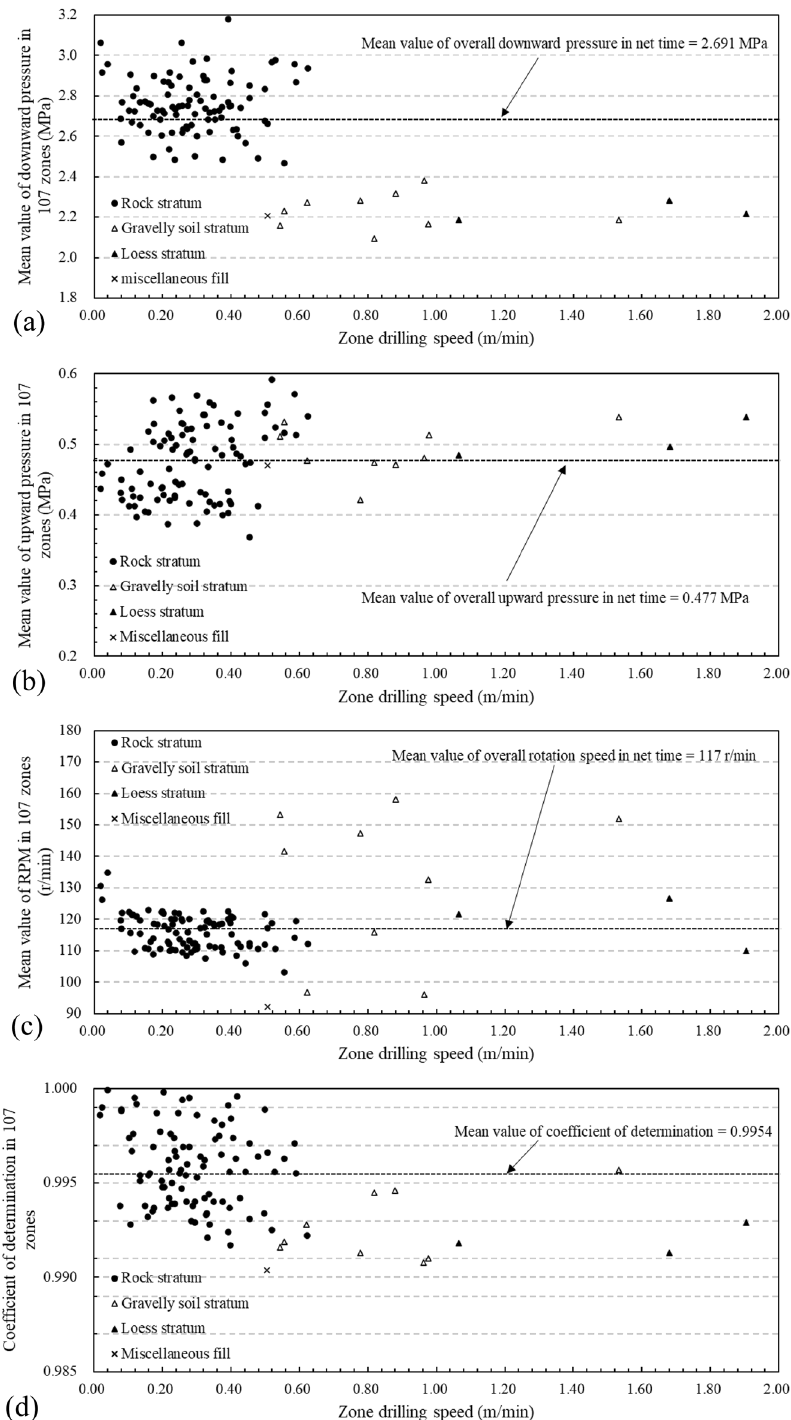
Figure 5. The relation between drilling speed of 107 depth zones and corresponding drilling parameters in the same zones ( a ) mean values of downward pressure, ( b ) mean values of upward pressure, ( c ) mean values of revolution, ( d ) coefficient of linear